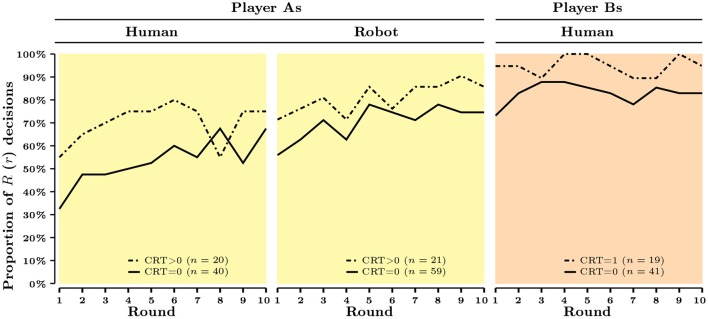
CRT score and aggregate behavior across rounds and treatments.